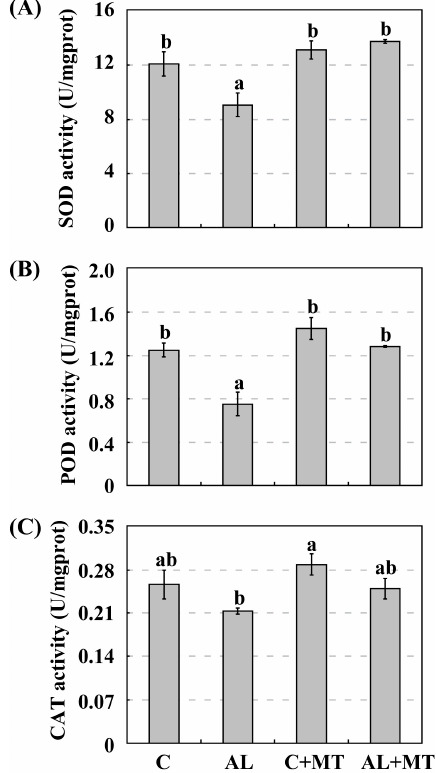
Figure 6. Activities of antioxidant enzymes in Malus hupehensis Rehd. seedlings in response to alkaline stress and/or melatonin treatment. ( A ) Superoxide dismutase (SOD); ( B ) Peroxidase III (POD); ( C ) Catalase (CAT). Lower-case letters indicate significant differences among treatments, based on Duncan’s multiple range test ( p < 0.05).